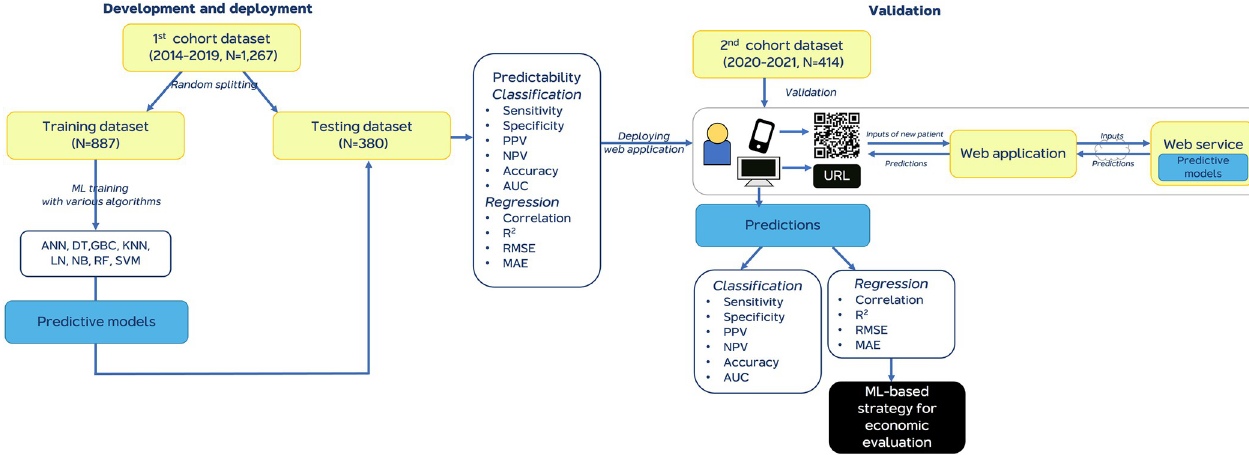
Fig 1. Workflow of the ML-based strategy for preoperative blood preparation. Abbreviations: ANN = artificial neural network, AUC = Area under the ROC curve, DT = Decision tree, GBC = gradient boosting classifier, MAE = Mean Absolute Error, ML = machine learning, NB = na ï ve Bayes, NPV = negative predictive value, PPV = positive predictive value, R 2 = R-squared, RF = random forest, RMSE = Root Mean Squared Error, SVM = support vector machine.